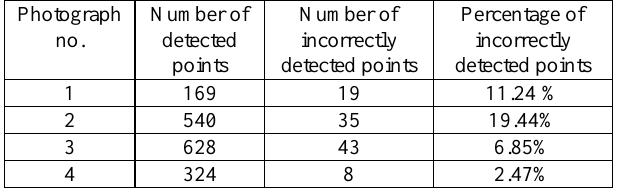
Table 3. Average deviation between check points on